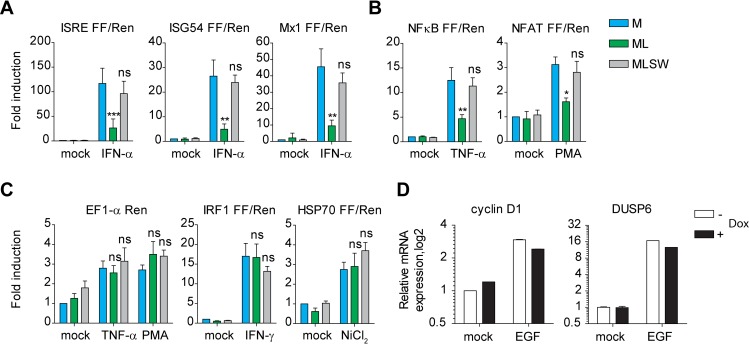
Multiple but not all inducible promoters are repressed by ML.(A-C) Reporter assays in HEK293 cells, where Firefly luciferase under indicated promoters was transfected together with EF-1a Renilla and M/ML/ML-SW. 24 h.p.t. cells were treated with indicated stimuli for 16 hours and the luciferase activity was measured. Shown is fold induction (mean and SD) over untreated cells from three independent experiments performed in six technical replicates. *—p<0.05; **—p<0.01; ***—p<0.001; ns–not significant. D) qPCR analysis of HeLa FlipIn cells expressing stably integrated ML from Tet-On promoter. HeLa cells were left untreated or treated with Doxycycline for 24h and subsequently stimulated with EGF for 16 hours. Total RNA was extracted and expression of indicated genes measured by qPCR. Shown are expression levels in relation to the non-Doxycycline treated unstimulated condition. The bar graphs show mean +/- error from two technical replicates and are representative of two independent experiments with similar results.